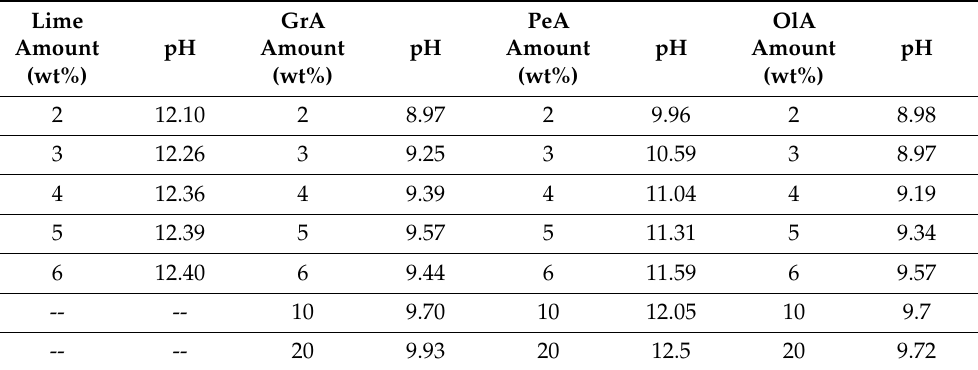
Table 1. Results of Eades and Grim tests performed on PR/lime and PR/ash mixtures. The amount of additive is indicated as a percentage of the dry weight of PR soil.